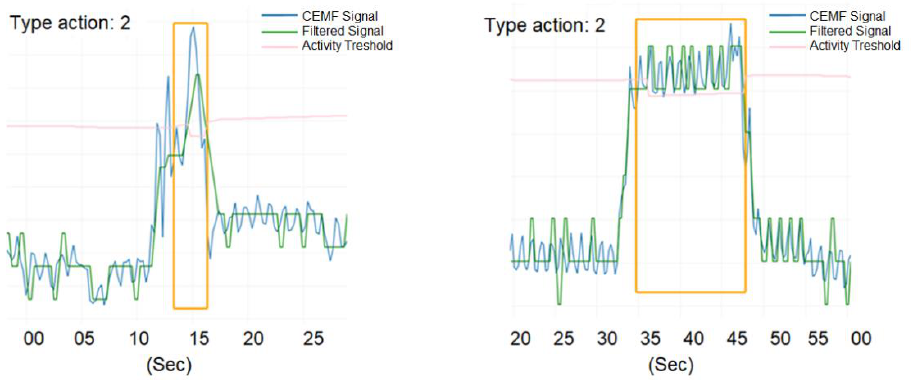
Figure 28. Validation events on the field.